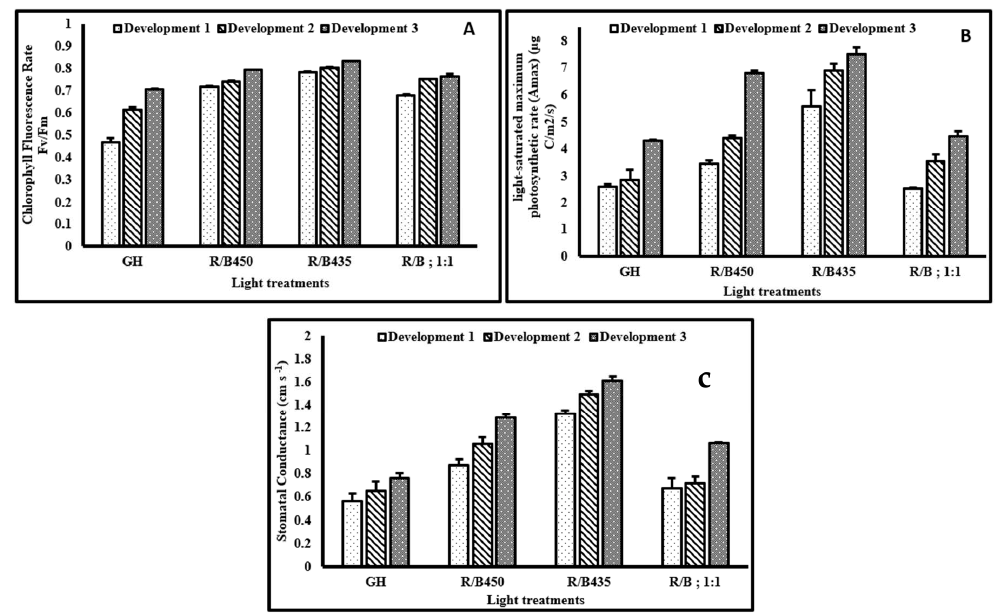
Figure 4. The effect of lighting treatment and development stage on various physiological aspects in sweet basil: ( A ) chlorophyll fluorescence rate (Fv/Fm) (LSD = 0.02), ( B ) light ‐ saturated maximum photosynthetic rate (A max ) (LSD = 0.6) and ( C ) stomatal conductance (LSD = 0.064 for the lighting treatments, LSD = 0.074 for the development stage).